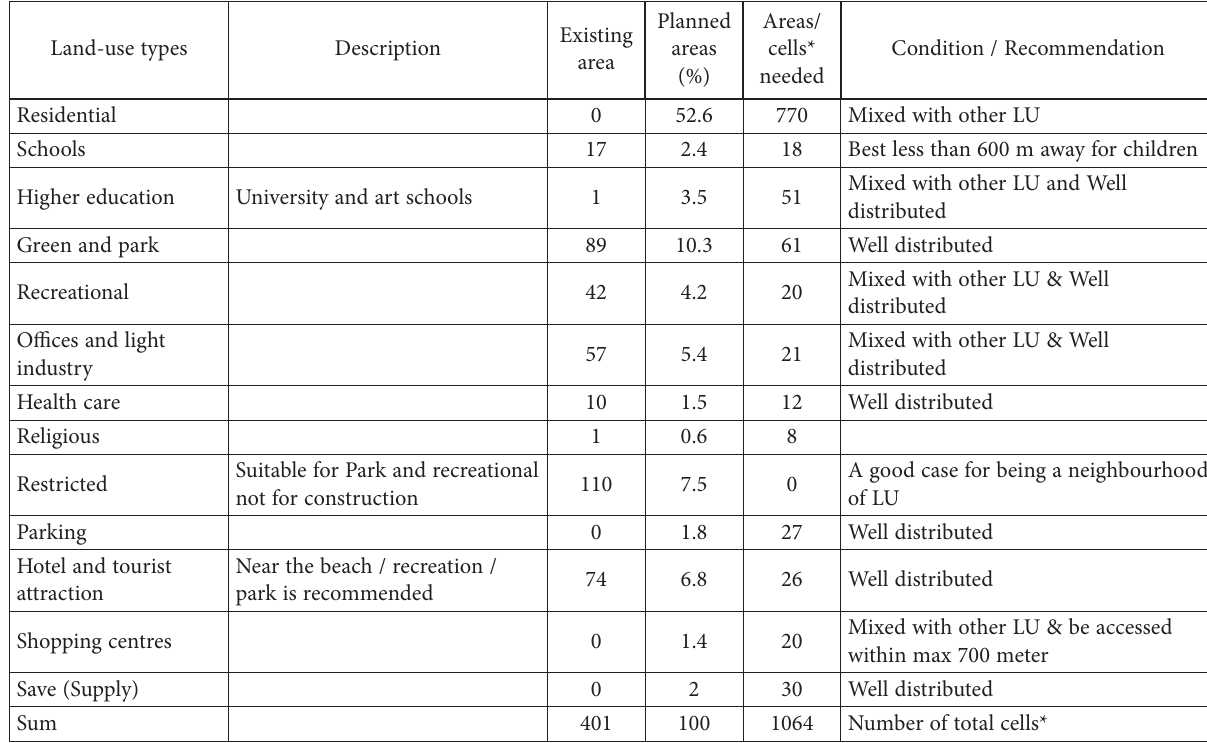
Table 1. Main land-use types in the study area, with existing and planned